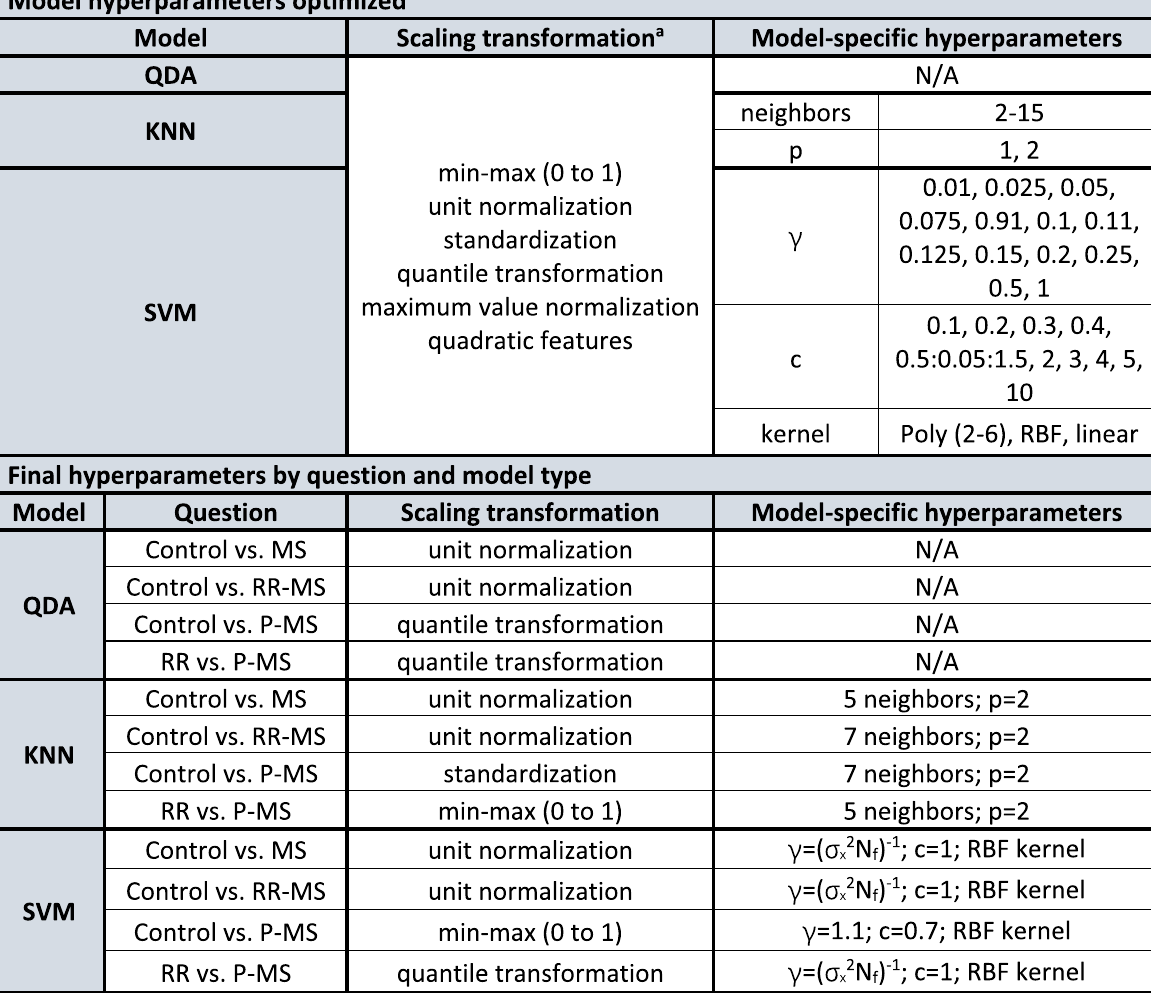
Table 1. Model hyperparameters optimized against average training cross-validation accuracy. a